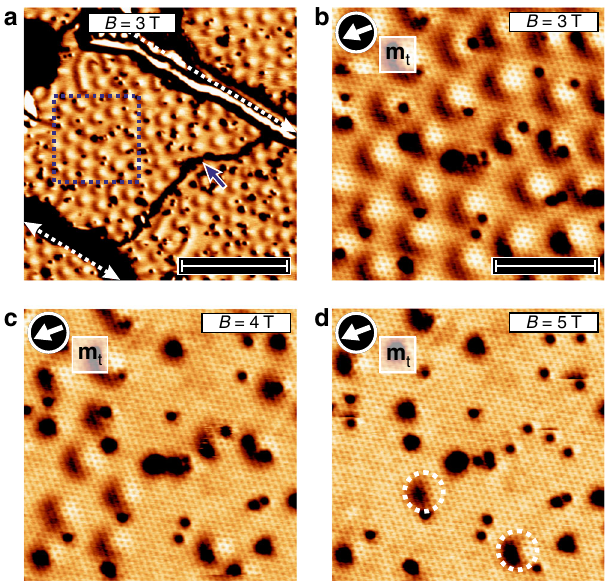
Fig. 3 Magnetic skyrmions in the H1-Fe phase. a SP-STM map of differential tunneling conductance of the hydrogenated Fe-DL, with large H1-Fe areas on three adjacent terraces. The Cr bulk tip used for this measurement is sensitive to the in-plane components of the sample magnetization; the dashed white lines are buried Ir steps and the black line indicated by the blue arrow is a phase domain between adjacent H1-Fe areas on the same terrace. It is evident that all magnetic objects show the identical spin- dependent two-lobe contrast, which demonstrates that they are skyrmions with unique rotational sense. Scale bar 25 nm. b – d Magni fi ed views of the magnetic skyrmions at increasing external magnetic fi elds as indicated in the panels. Scale bar 8 nm. In d , two remaining skyrmions are shown by circles. For corresponding STM topography images, see Supplementary Fig. 4. Measurement parameters: U = − 0.2 V; I = 1 nA; T = 4.2